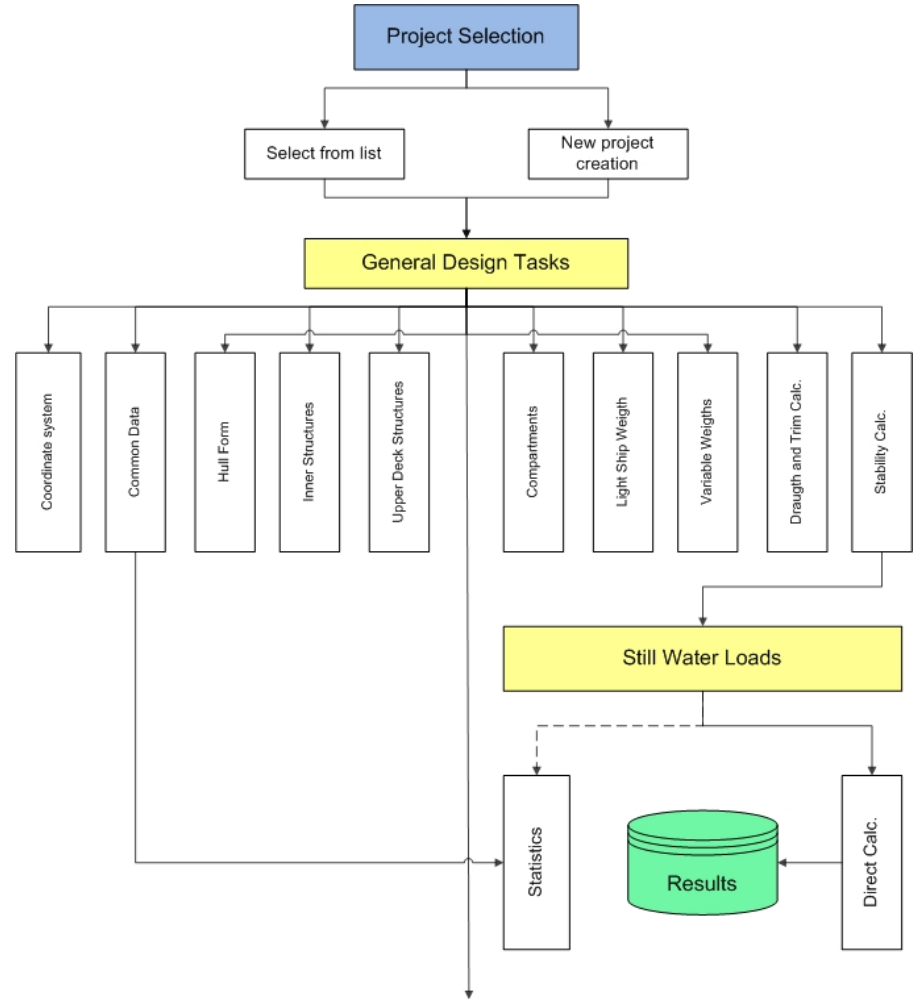
Figure 2. General design block of the parametric computer-aided design system.